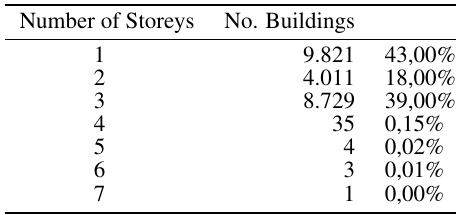
Table 2. Building’s distribution by number of storeys above ground